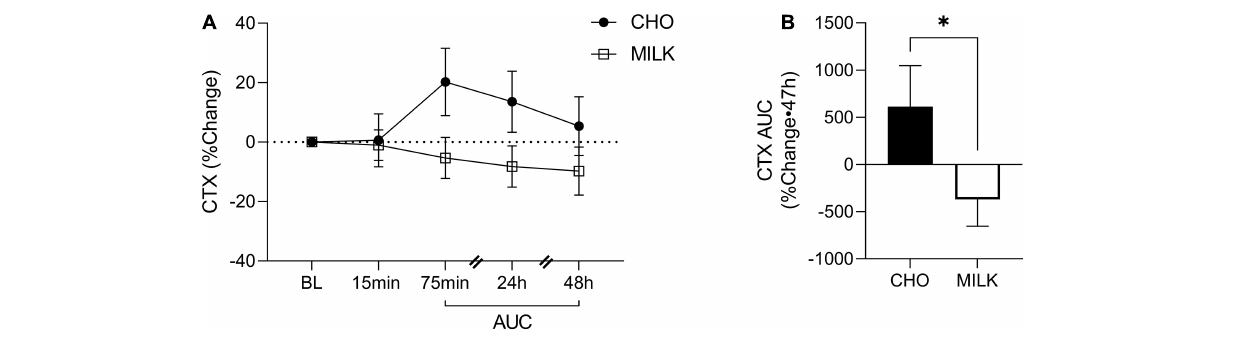
FIGURE 2 | Percent change post-exercise (A) and area under the curve from 75-min to 48-h (B) for C-terminal crosslinked telopeptide of type-I collagen (CTX) in the CHO and MILK trials. Values are means ± SEM. n = 13. ∗ Significant difference between conditions based on a paired t -test ( p = 0.03). BL, baseline; AUC, area under the